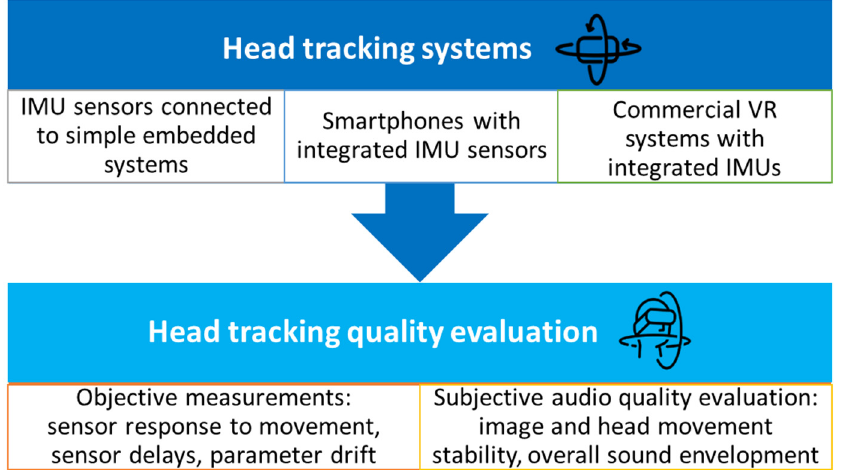
Figure 1. The outline of the AUTAURA project: quality evaluation of head-tracking systems based on IMU sensors.